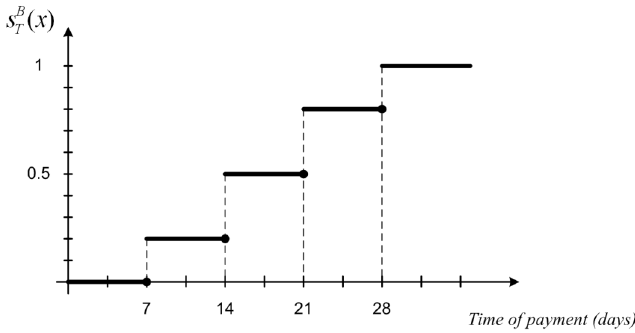
Figure 3. The Buyer’s membership function for time of payment